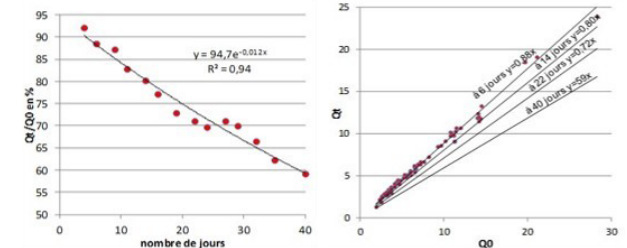
Figure 3. Méthode des correlations.